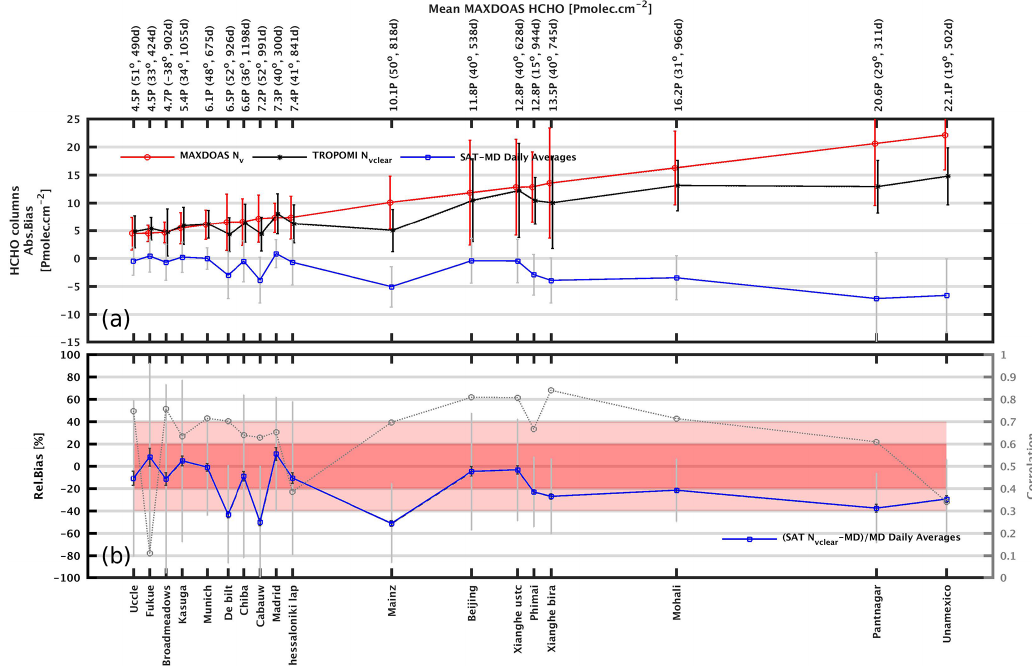
Figure 10. Absolute ( a , blue line) and relative biases (b) between MAX-DOAS and TROPOMI HCHO daily averaged tropospheric columns in a circle of 20km radius around the stations. Regions are sorted as a function of the median MAX-DOAS HCHO column. In (a) , the median MAX-DOAS (red) and TROPOMI (black) columns are plotted together with the differences. Error bars (in grey) represent the median abso- lute deviations (MADs) of the columns and of the differences. Statistical ErrB is also plotted for the relative bias (in blue). Pink areas indicate 20% and 40% bias. The correlation between the daily observations is given in (b) (grey circles). (Pmolec.cm − 2 = 1 × 10 15 molec.cm- 2 .)